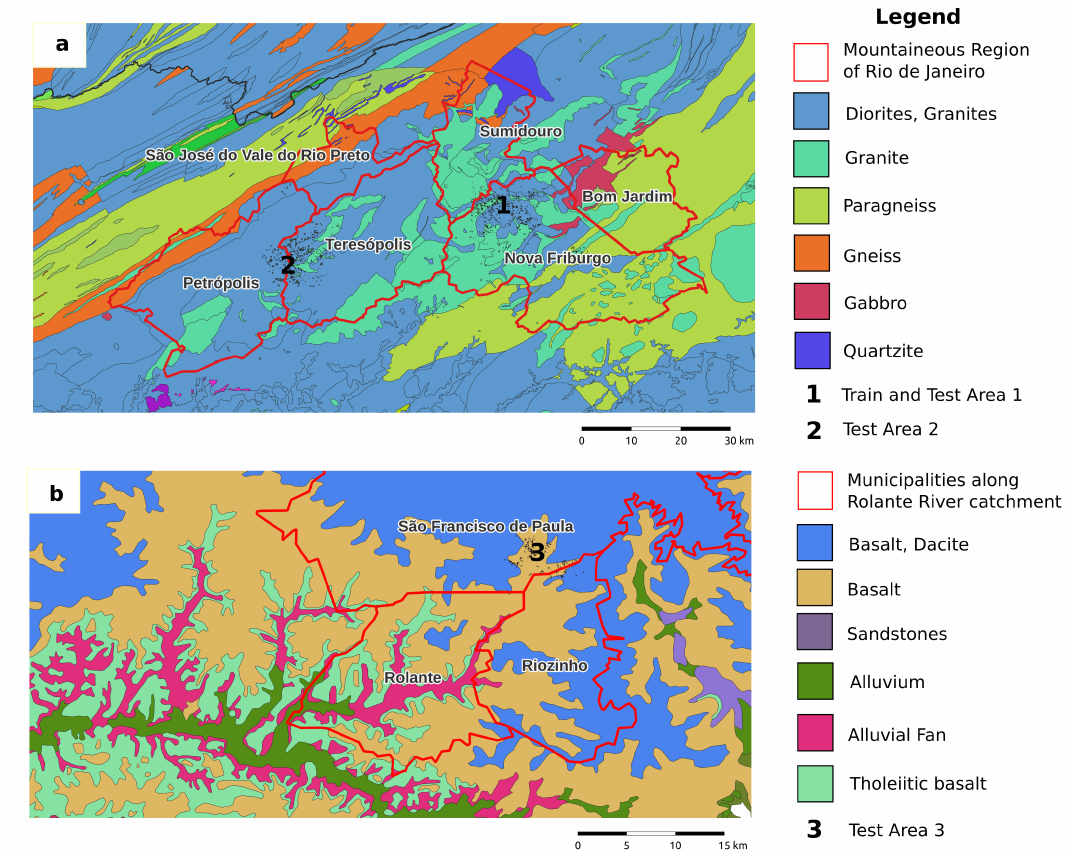
Figure 2. Simplified geological maps of the study areas. ( a ) Geological map of the mountainous region of Rio de Janeiro. ( b ) Geological map of the Rolante River